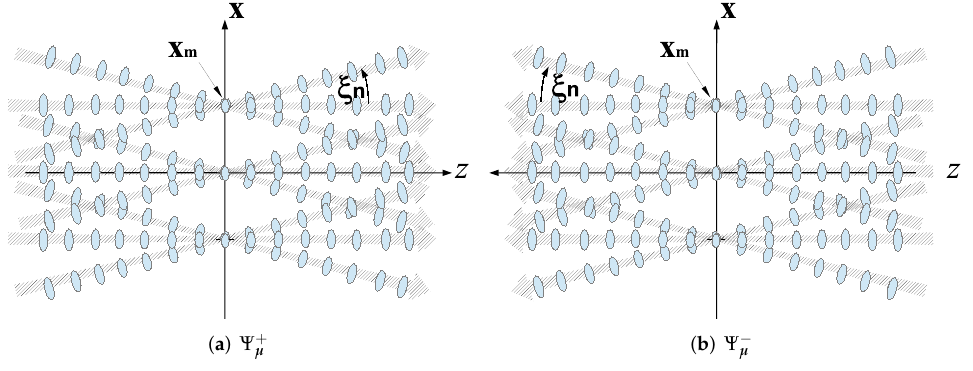
Figure 3. The forward/backward propagating beam frames Ψ ± µ . ( a ) The forward and ( b ) the backward beam frames Ψ ± µ . The BFs are illustrated by the hatched arrows. The ellipses correspond to the pulsed-beam-frames that are used in the TD formulations and are not considered here (see [21]). As has been established by the beam frame theorem in [20], the beam-sets constitute frames (hence referred to as “beam frames” (BF)) at any z = const . plane